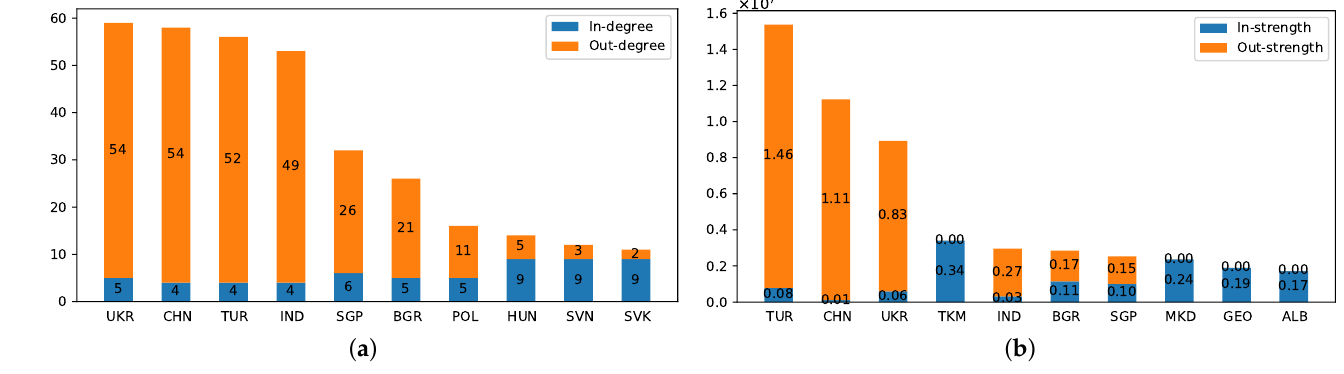
Figure 4. Top 10 countries in the EGSR transmission network in terms of ( a ) degree and ( b ) strength. (Unit of strength: